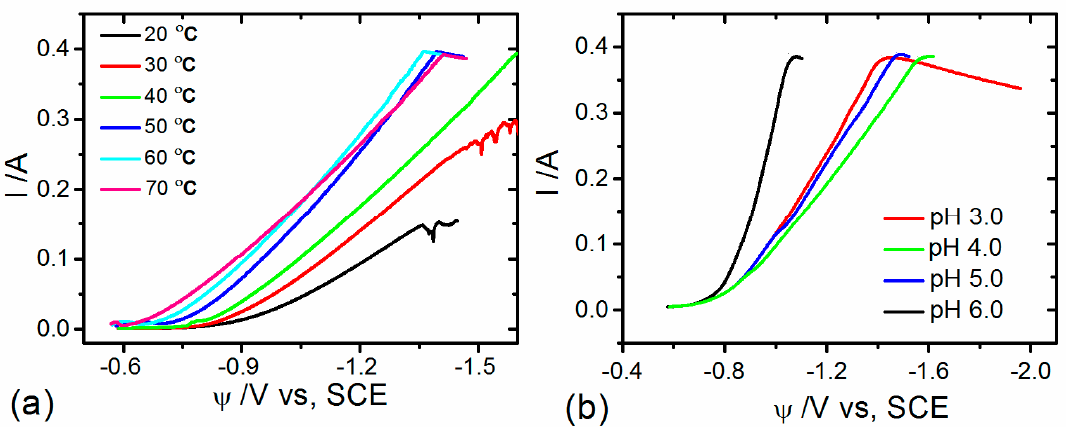
Figure 1. ( a ) Effects of temperature and ( b ) pH value on the cathode polarization of Ni electrodeposition from the modified Watts bath.